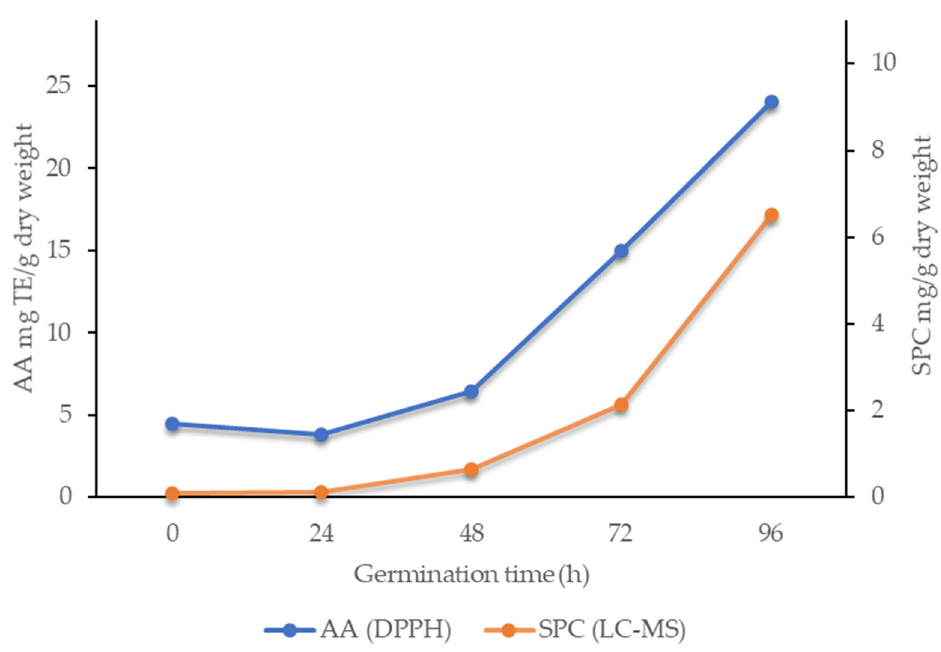
Figure 3. Comparison between antioxidant activity (AA) determined by the DPPH method and the sum of the phenolic compounds (SPC) determined by liquid chromatography-mass spectrometry (LC-MS) for the free fraction of the germinating buckwheat seed extracts.